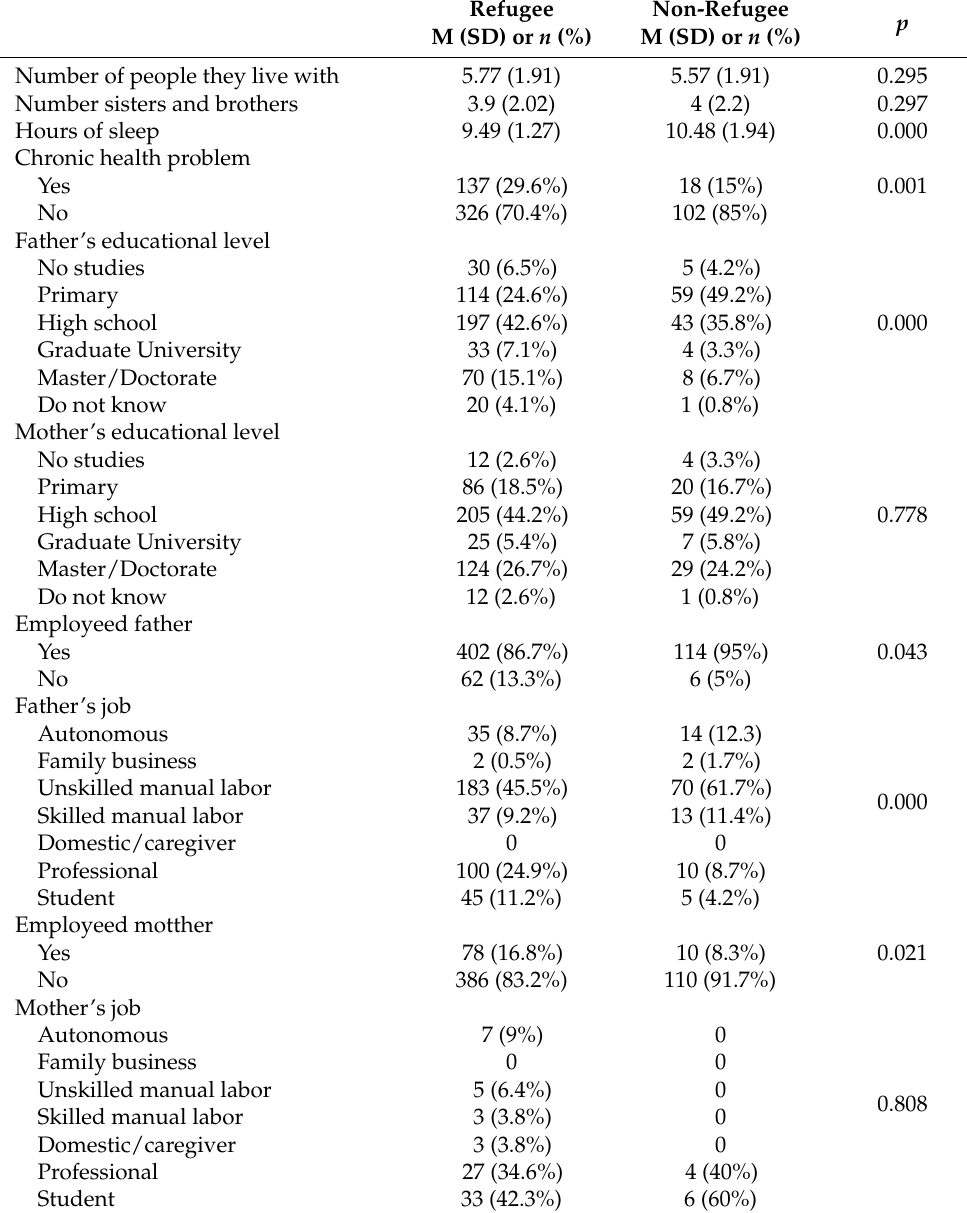
Table 2. General information on the sample and sociodemographic data of the